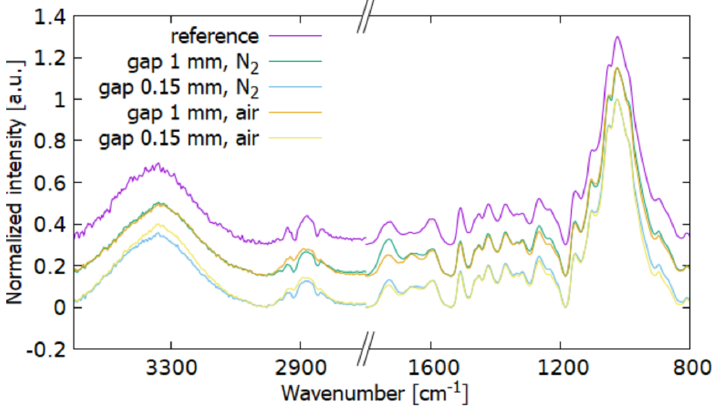
Figure 8. FTIR spectra comparison of the T180 wood after plasma treatment under N 2 and air atmosphere.